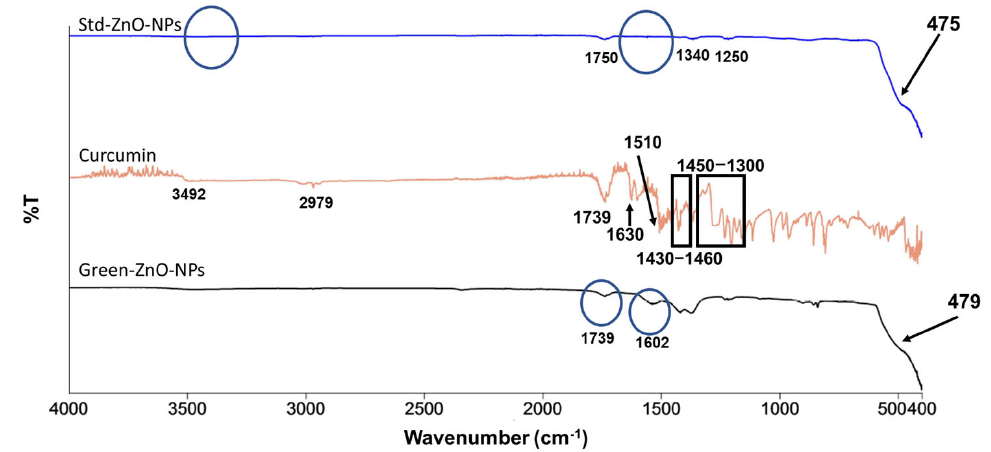
Figure 3. FTIR spectra of Std-ZnO-NPs ( up ), curcumin ( middle ), and Green-ZnO-NPs ( down ). The circles in Std-ZnO-NPs show that there were no peaks at 3500 cm − 1 and 1600 cm − 1 , confirming the absence of hydroxyl groups on ZnO NPs surfaces.